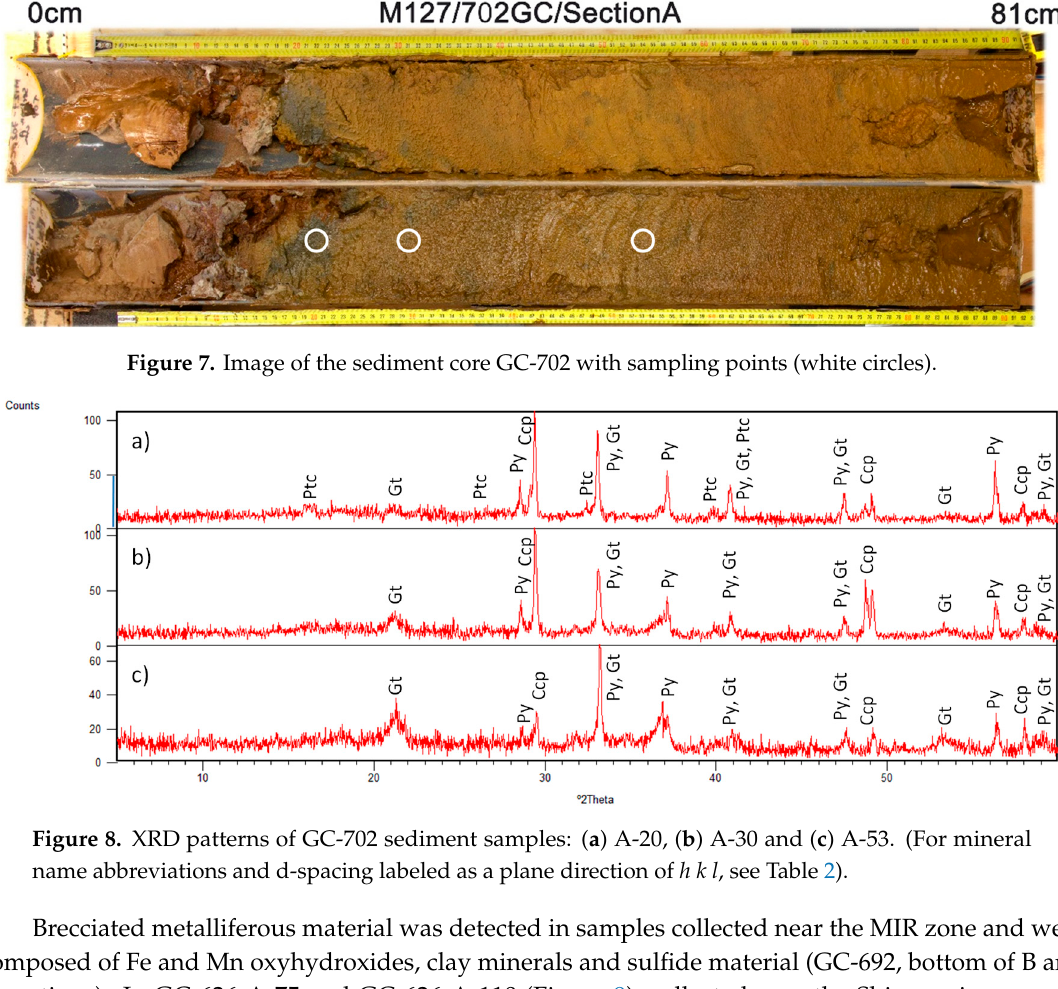
Figure 8. XRD patterns of GC-702 sediment samples: ( a ) A-20, ( b ) A-30 and ( c ) A-53. (For mineral name abbreviations and d-spacing labeled as a plane direction of h k l , see Table 2).